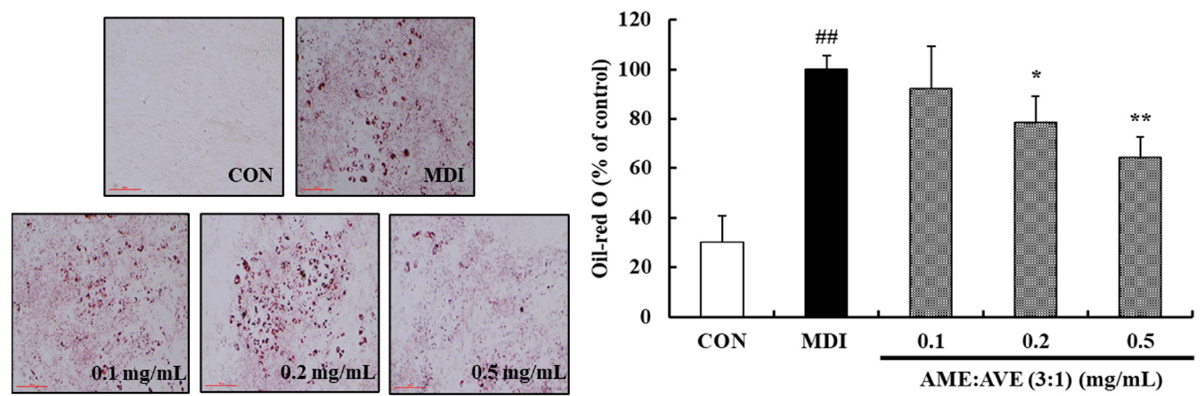
Figure 2. Effects of Atractylodes macrocephala and Amomum villosum extracts (3:1) on adipocyte differentiation in 3T3-L1 preadipocytes. Confluent 3T3-L1 preadipocytes were differentiated into adipocytes in media supplemented with or without AME:AVE (3:1) for 6 days. Lipid accumulation was measured via Oil-Red O staining and absorbance. Data represent mean ± SD of three independent experiments. Scale bar = 500 μ m. CON, only dimethyl sulfoxide (DMSO) treated no differentiation control; MDI, only 3-isobutyl-1-methylxanthine, dexamethasone, and insulin treated differentiation control. ## p < 0.01 vs. CON group. * p < 0.05, and ** p < 0.01 vs. MDI group.